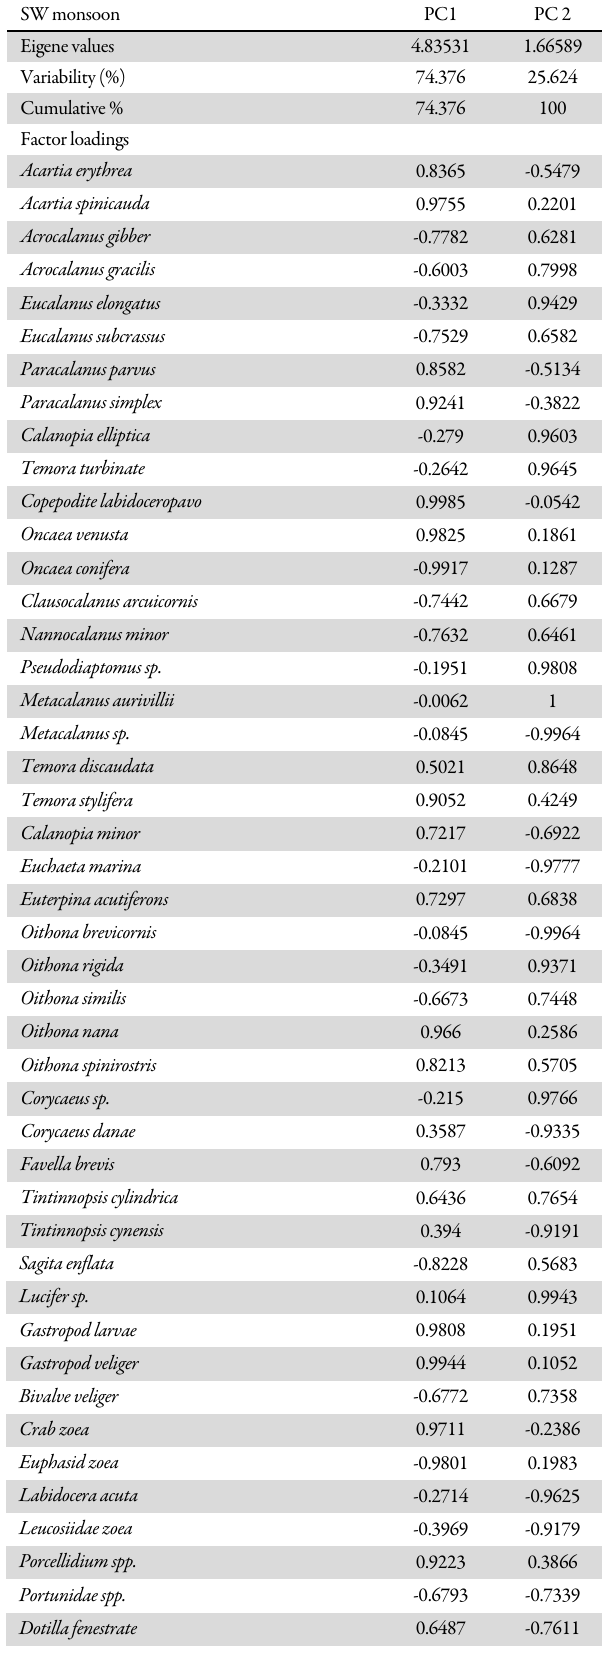
Table 3. Eigene analyses of the correlation matrix loadings of the significant principal components in SW